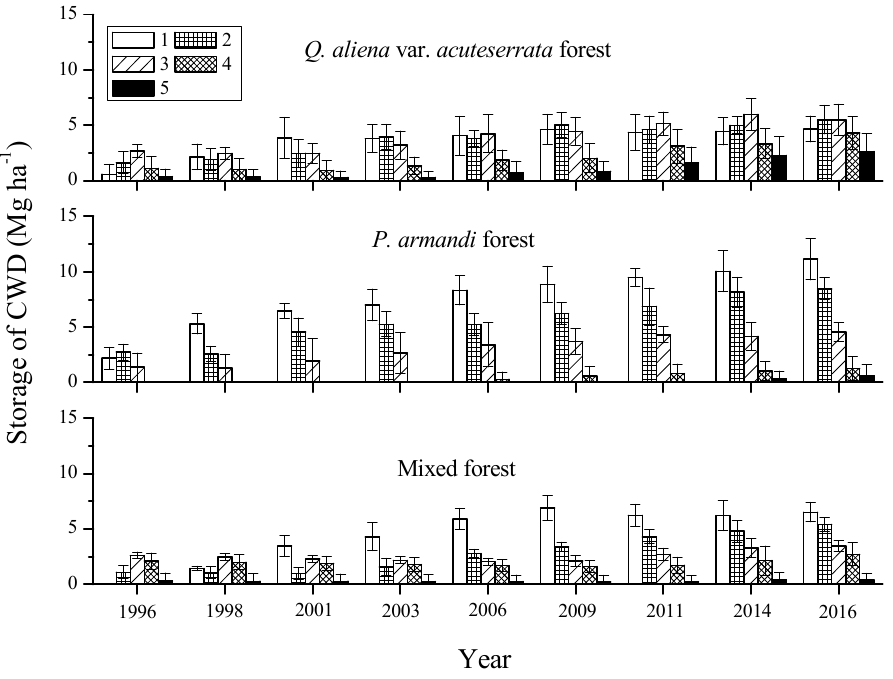
Figure 6. Mass of CWD decay classes at the nine tree censuses during 1996–2016 for the three forest types in the Huoditang Experimental Forest Farm in the Qinling Mountains (China). The error bars represent the standard error of the mean, and are based on the plot as the experimental unit ( n = 6).